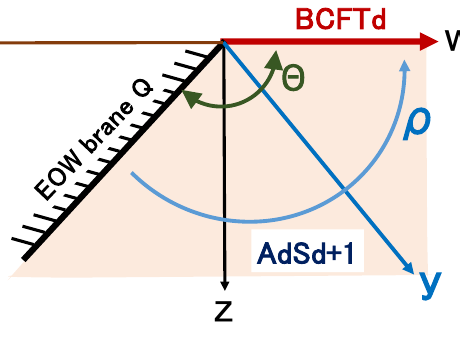
Figure 2 . A sketch of AdS/BCFT